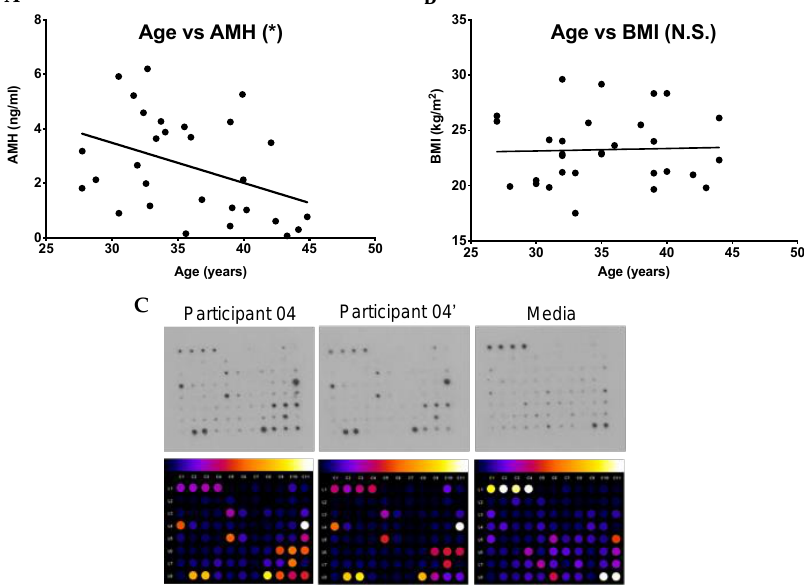
Figure 1. Relationship between age and anti-Müllerian hormone (AMH) and body mass index (BMI) and sample cytokine antibody array ( A ) Graph demonstrating that with increasing age, there was a statistically significant inverse correlation with AMH in our sample population (total n = 30). ( B ) Graph demonstrating that with increasing age, there was no statis- tically significant correlation with BMI in our population. ( C ) Representative human cytokine array C5 performed on the follicular fluid from the first follicle aspirated from either the right (participant 04) or left ovary (participant 04′) fro m a single participant. One array was incubated in media alone to determine the background and thus, establish signal thresh- olds. The lines in ( A ) and ( B ) correspond to the fitted regression equation. * p < 0.05, N.S. = no statistical significance .